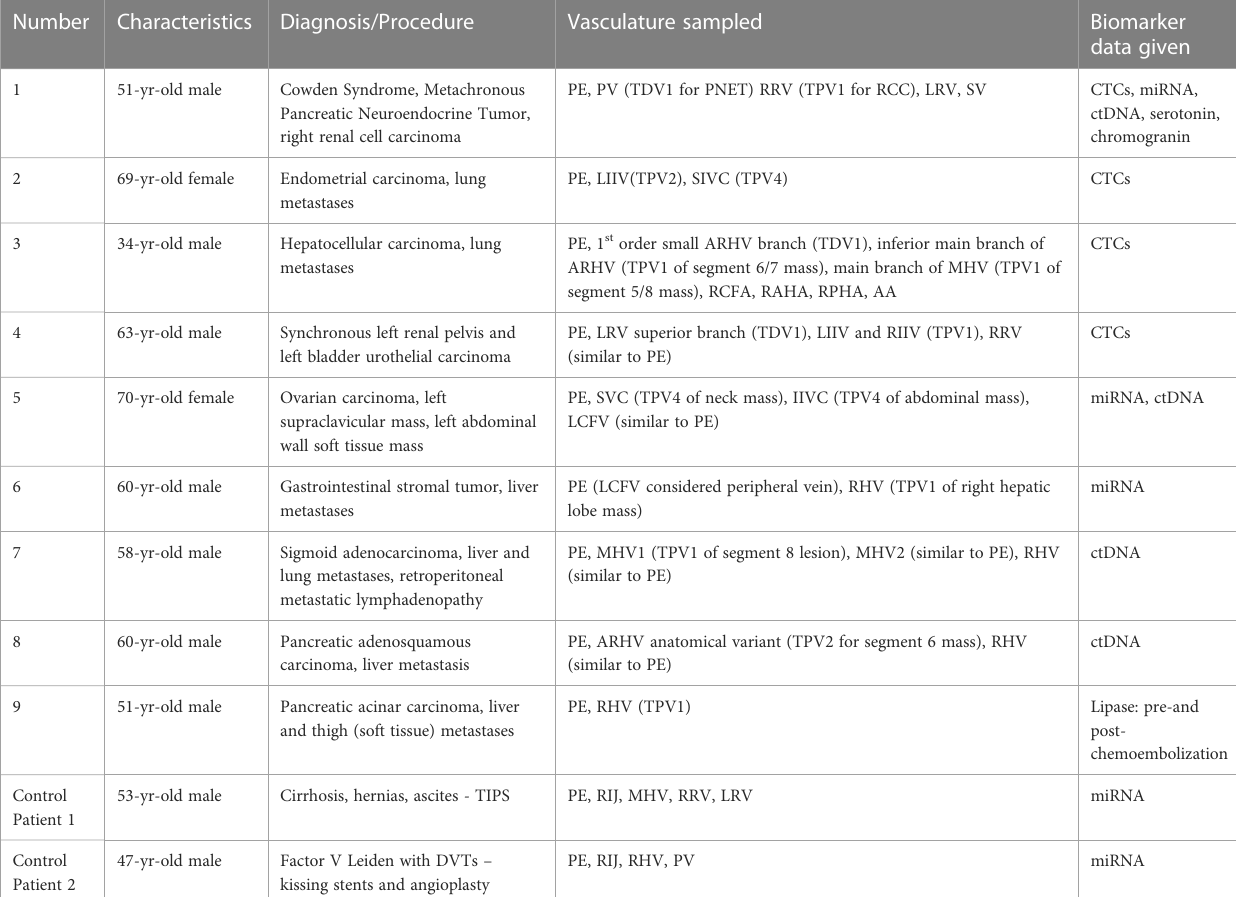
TABLE 1 Summary of the clinical details, vascular beds sampled, and biomarkers analyzed in this case series.